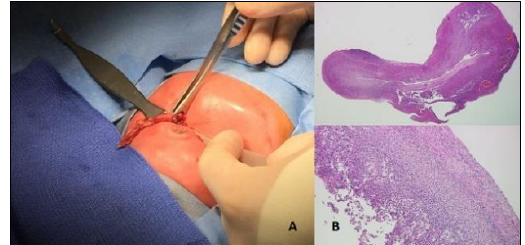
Figure 2: A) Intra-operative picture demonstrating the perforated appendix delivered through transverse supra-umbilical skin inci- sion. B) Pathologic exam of the appendix demonstrating mucosal necrosis with transmural acute inflammation (HE, x20), and